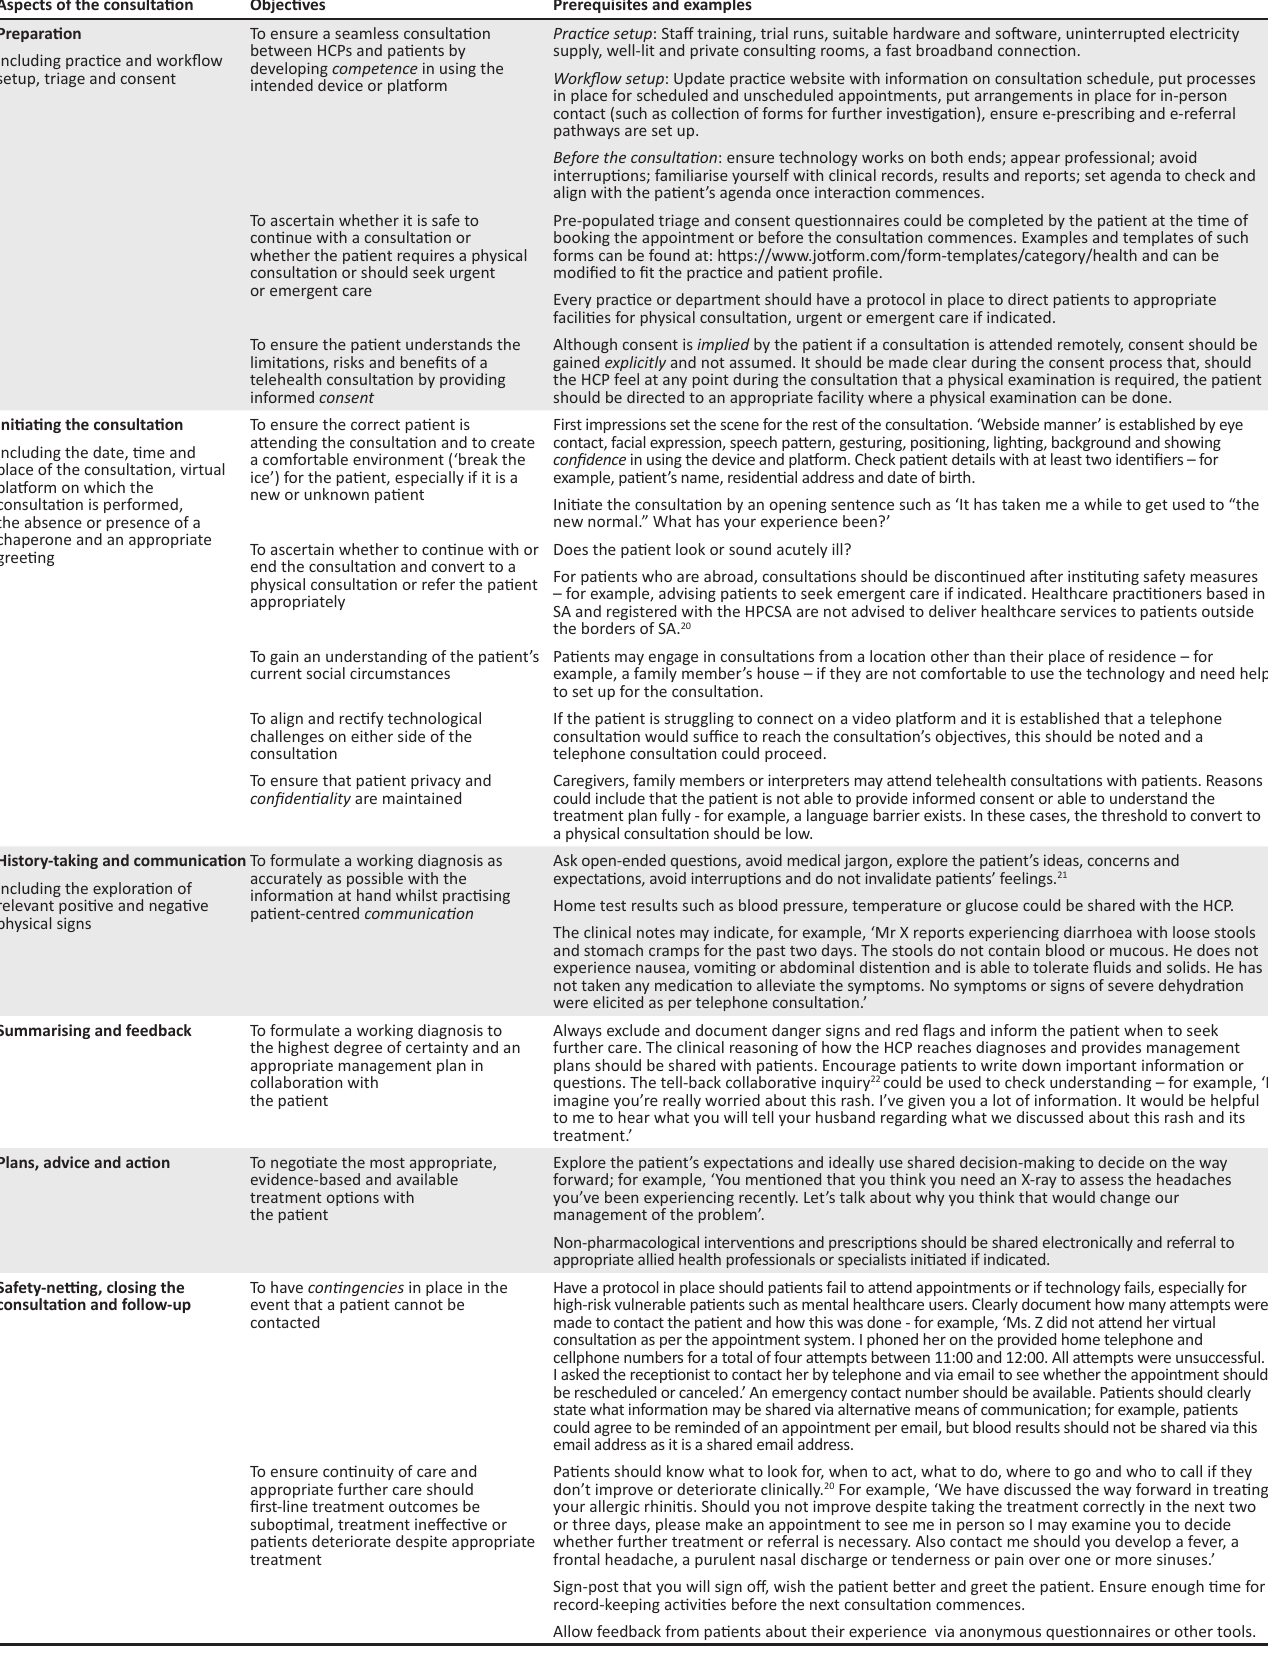
TABLE 1: How to interact with patients remotely: communication considerations and